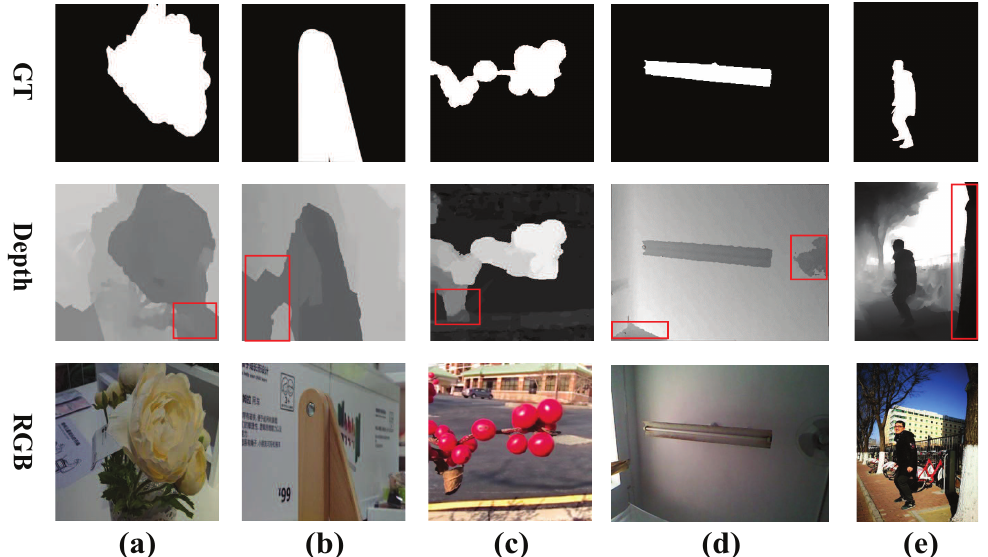
Figure 1. Visual demonstrations of ambiguities among different modalities. The red boxes indicate salient differences between depth map and RGB image. ( a – e ) present five examples of the ambigity between RGB and Depth images, respectively. GT means the ground truth of saliency